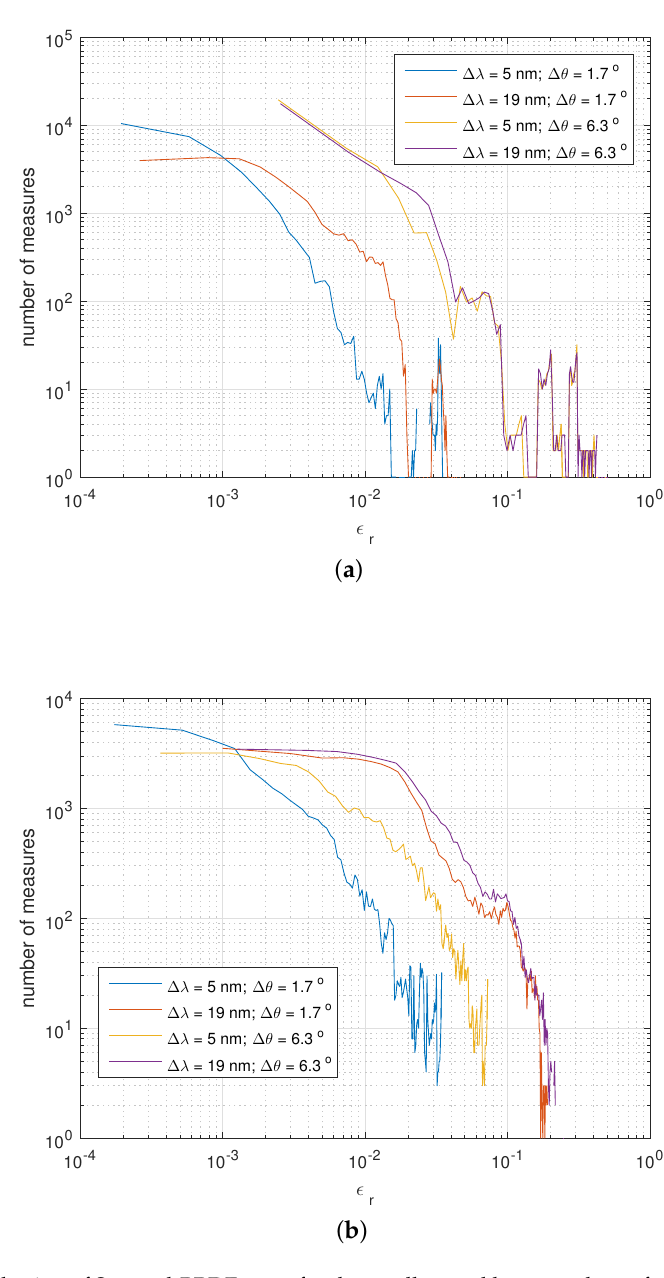
Figure 4. Distribution of Spectral-BRDF-error for the smallest and largest values of spectral and angular bandwidths used in this work.( a ) Interference-based special effect coating; ( b ) Diffraction-based special effect